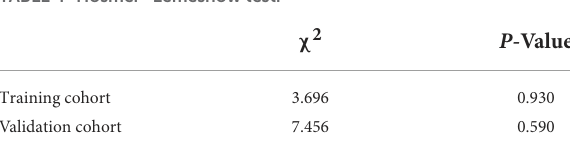
TABLE 4 Hosmer–Lemeshow